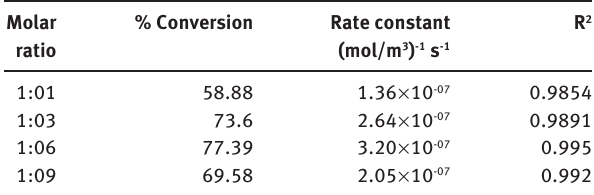
Table 2 Kinetic analysis for the effect of molar